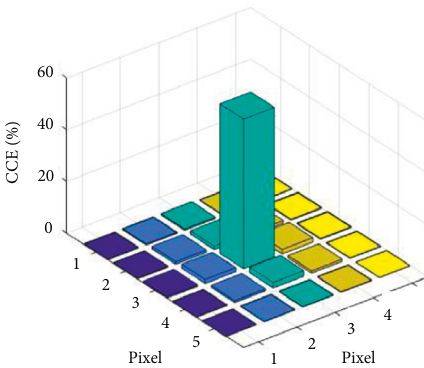
Figure 6: Charge collection efficiency in the 5 × 5 pixel region.